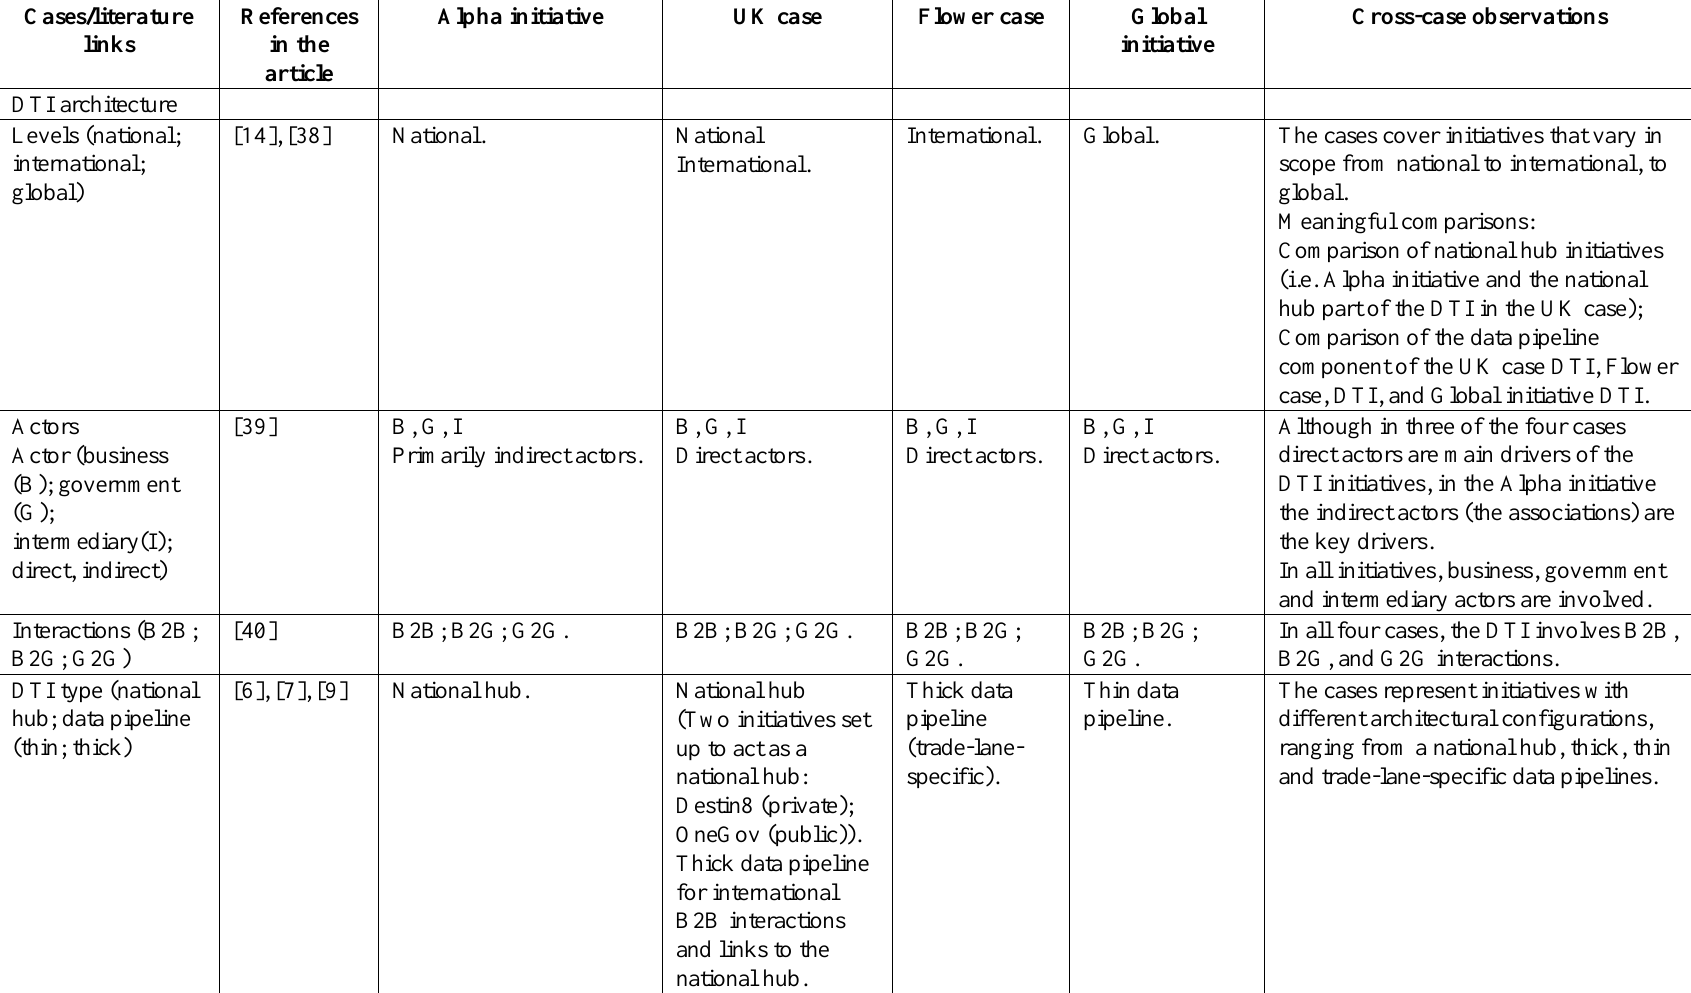
Table A1. The architecture component of the DTI framework and links to the four cases and the references of the